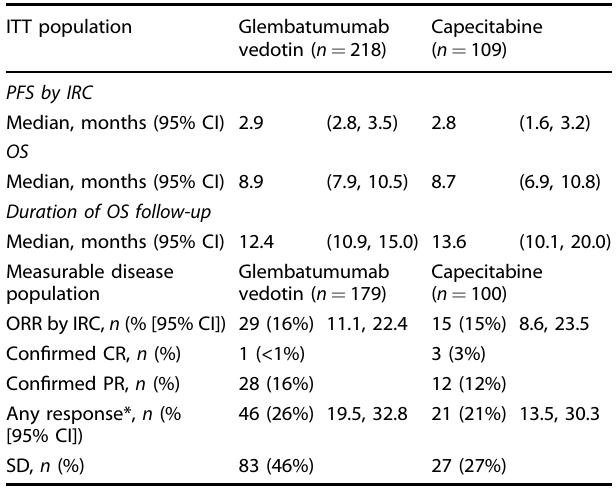
Table 3. Antitumor